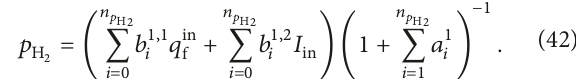
Table 5: Parameters of the reduced-order hydrogen pressure model of order 𝑛 𝑝 𝑛 𝑝 H